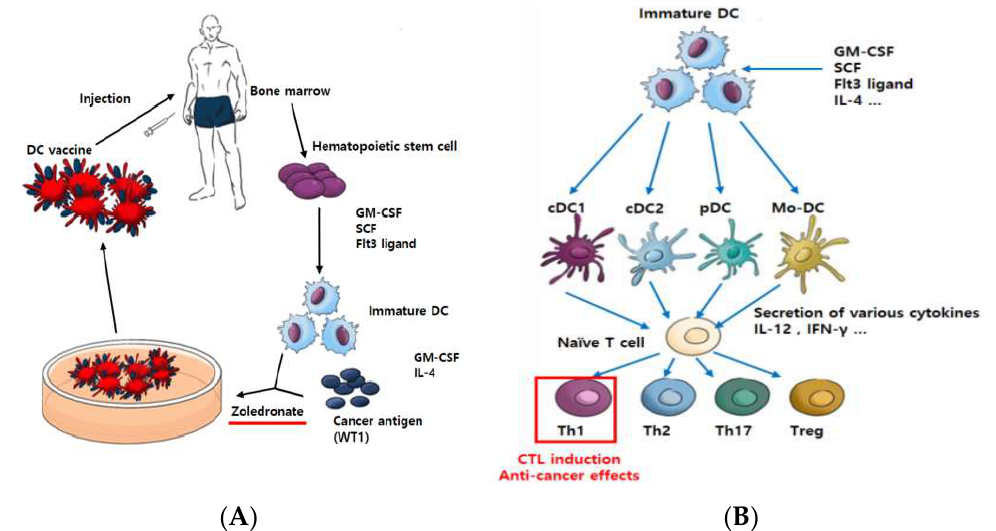
Figure 1. Scheme of vaccination with ex vivo pulsed-DC (against cancer). Dendritic cells play an important role in deciding the direction of host immune reactions, CTL induction, and anti-cancer effects. CellgramDC-WT1 (CDW), a Th1-inducing type of dendritic cell vaccine, is made as follows. Hematopoietic stem cells (CD34+ cells) are isolated from the patient’s bone marrow for proliferation and differentiation into DC. Then, the cells are pulsed using WT1 protein and made into a DC vaccine using zoledronate as a maturation factor ( A ). Through different growth factors, such as GM-CSF and FLT3-ligand, immature DC differentiate into several types of DC. These differentiated DC secrete various cytokines to regulate the immune response. Specifically, naïve T cell differentiation into Th1-type T cells can occur, which directly induces CTL reactions to cause anti-cancer effects ( B ).